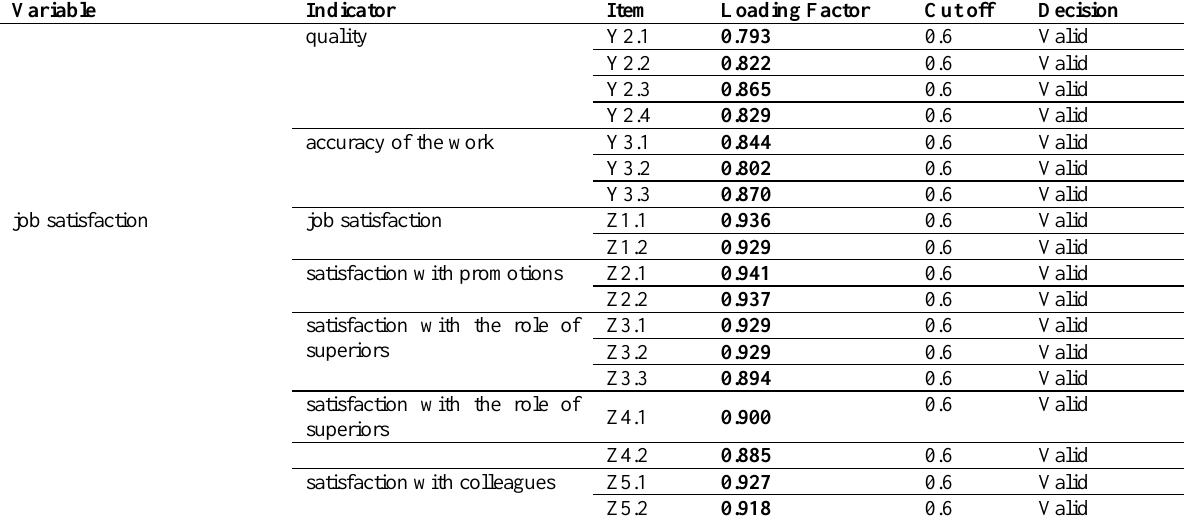
Table 3: Results of Convergent Validity and Discriminant Validity